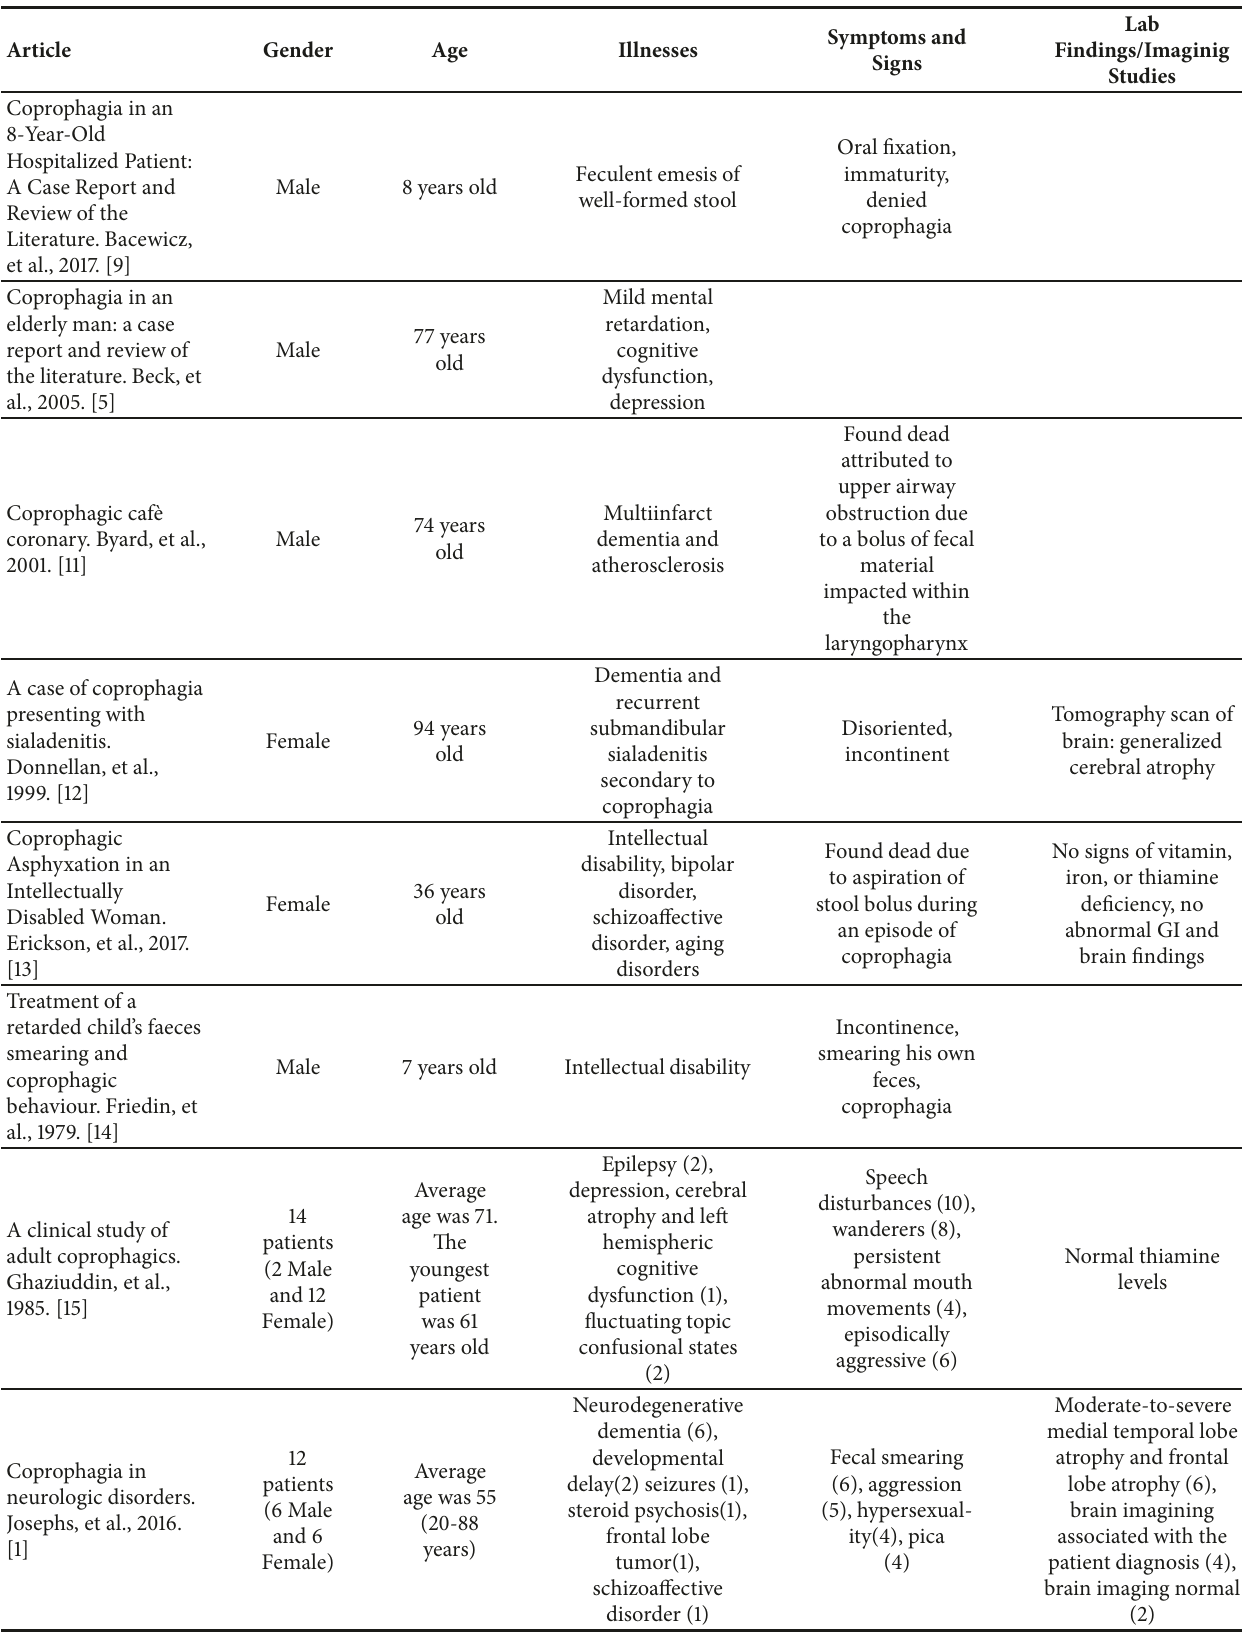
Table 1: Review of selected literature on the comorbidities and concurrent symptoms of